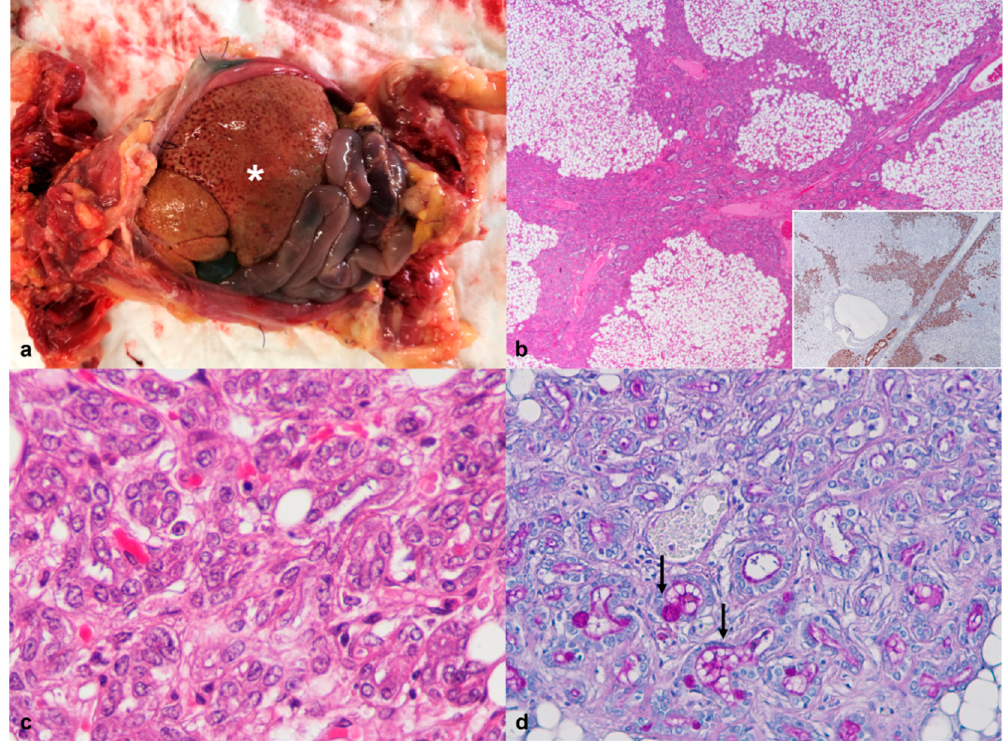
8 of 19 including bone (*; HE, 20×). Inset: note the bone invasion by neoplastic cells and osteolysis (HE, 200×). 3.3.2. Liver